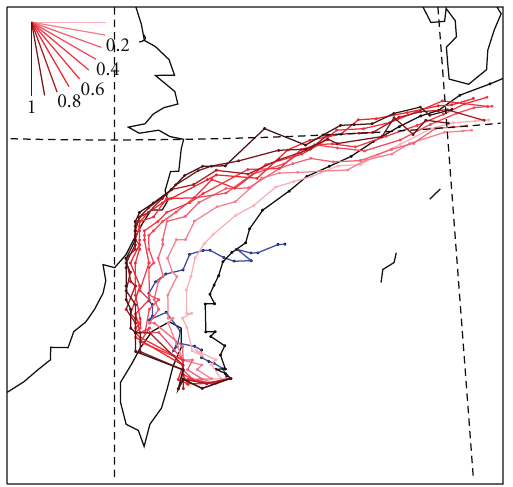
Figure 6: The forecasts initialized at 18UTC, 12 September 2008, with LEN SCALING = 1.0 and VAR SCALING = 0.1–1.0 step 0.1. Color scale is shown at the upper left corner, black curve is the control run without AIRS data, and blue curve is the observed track.